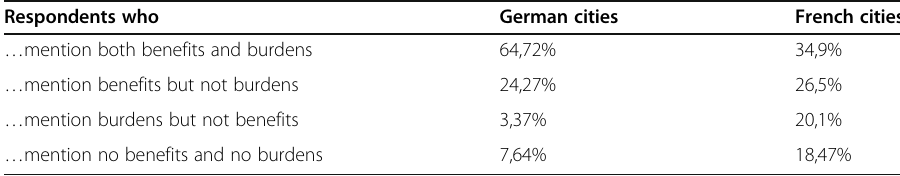
Table 1 Benefits and burdens of diversity, contrasting or